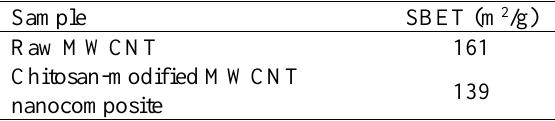
Table 2. BET of raw MWCNT and chitosan-modified MWCNT